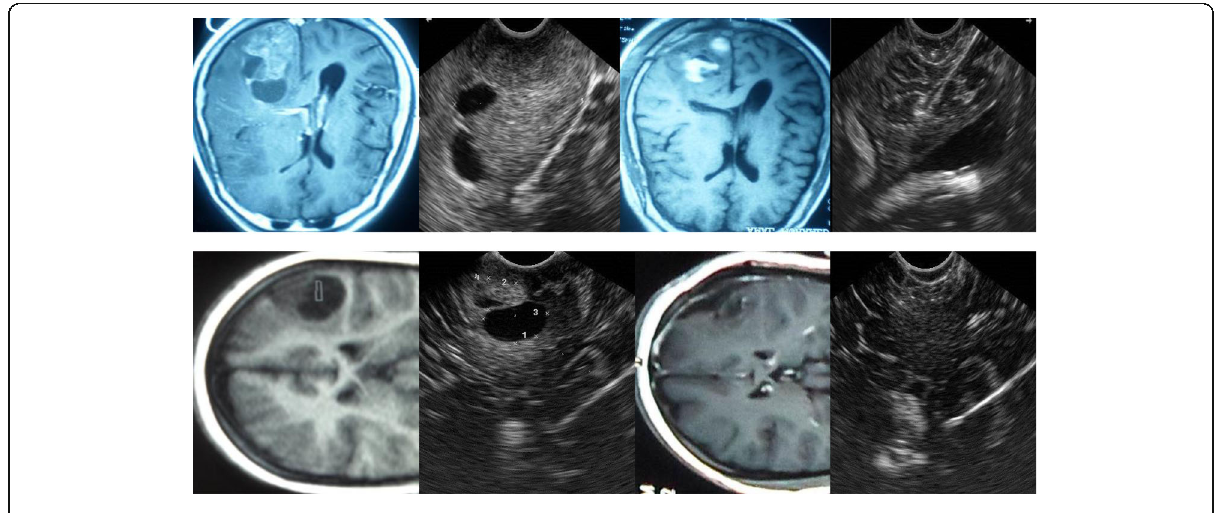
Fig. 6 Gross total resection of astrocytoma grade 3 (TWO CASES), preoperative and postoperative MRI T1 with contrast and IOUS images. NOTE; the hyperechoic choroid plexus in both cases became more clear after tumors